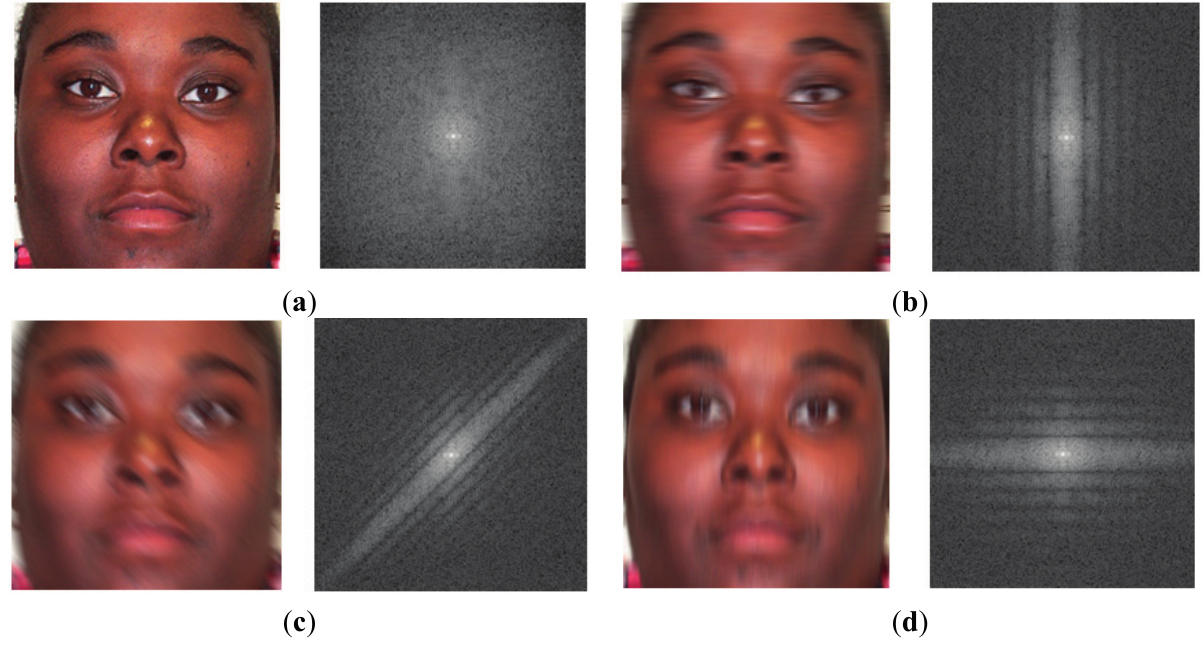
Figure 10. Example of power-spectrum images of focused and motion-blurred images at different motion blur directions: ( a ) focused image without motion blurring; ( b ) motion blur with direction of 0° and motion length of 15; ( c ) motion blur with direction of 45° and motion length of 15; ( d ) motion blur with direction of 90° and motion length of